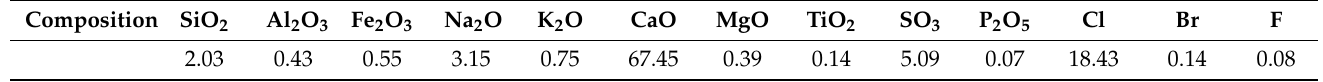
Table 1. Chemical composition of the waste (wt.%).